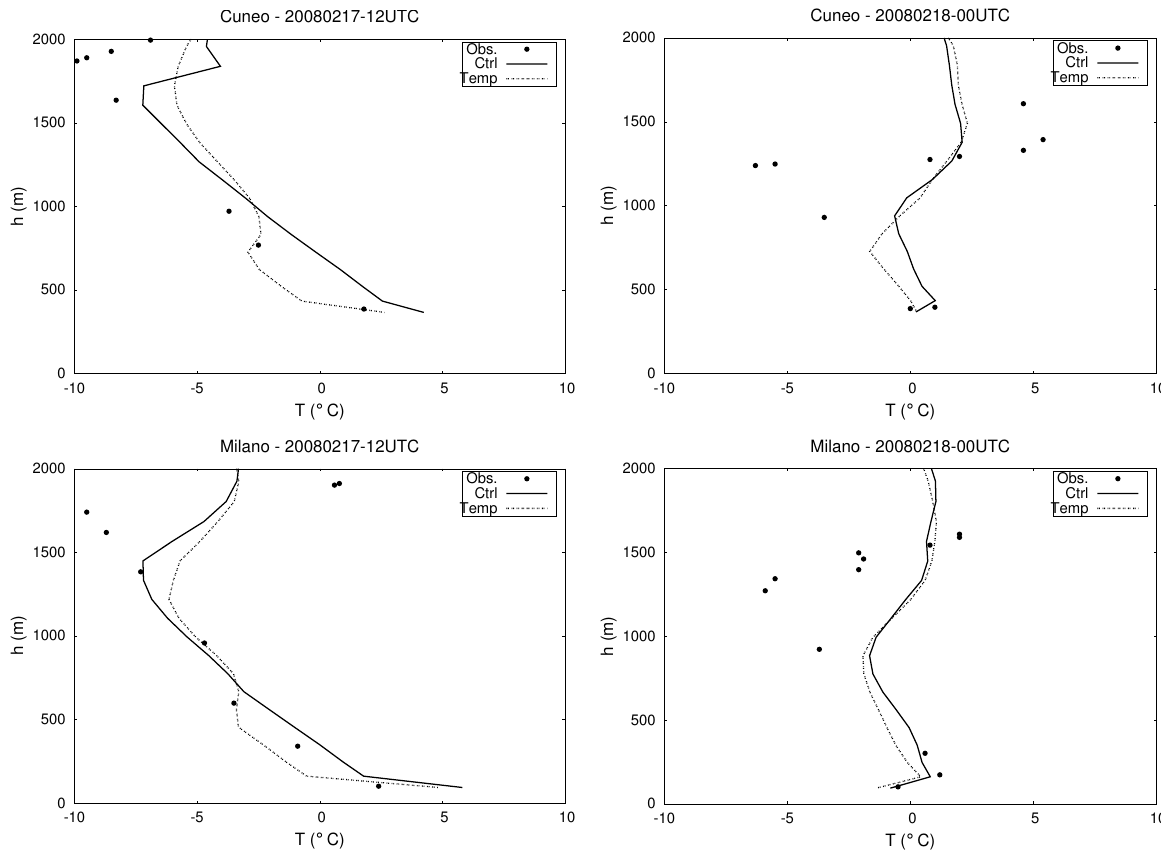
Fig. 16. Vertical temperature profile in Cuneo (above) and Milano (below), at +12h (left) and +24h (right) for the February 2008 case. The dots represent the observations, the continuous line represents the Ctrl run and the dotted line represents the Temp run.